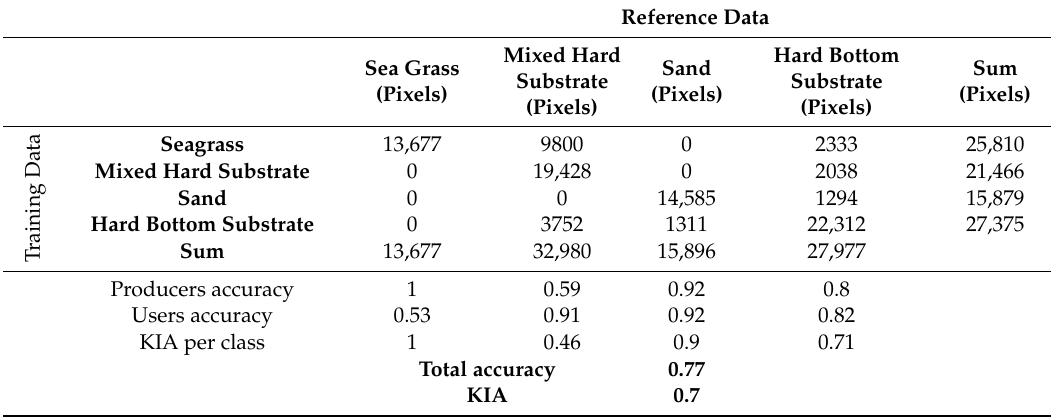
Table 5. Accuracy matrix for the multispectral orthomosaic with k-nearest neighbor as the classifier.